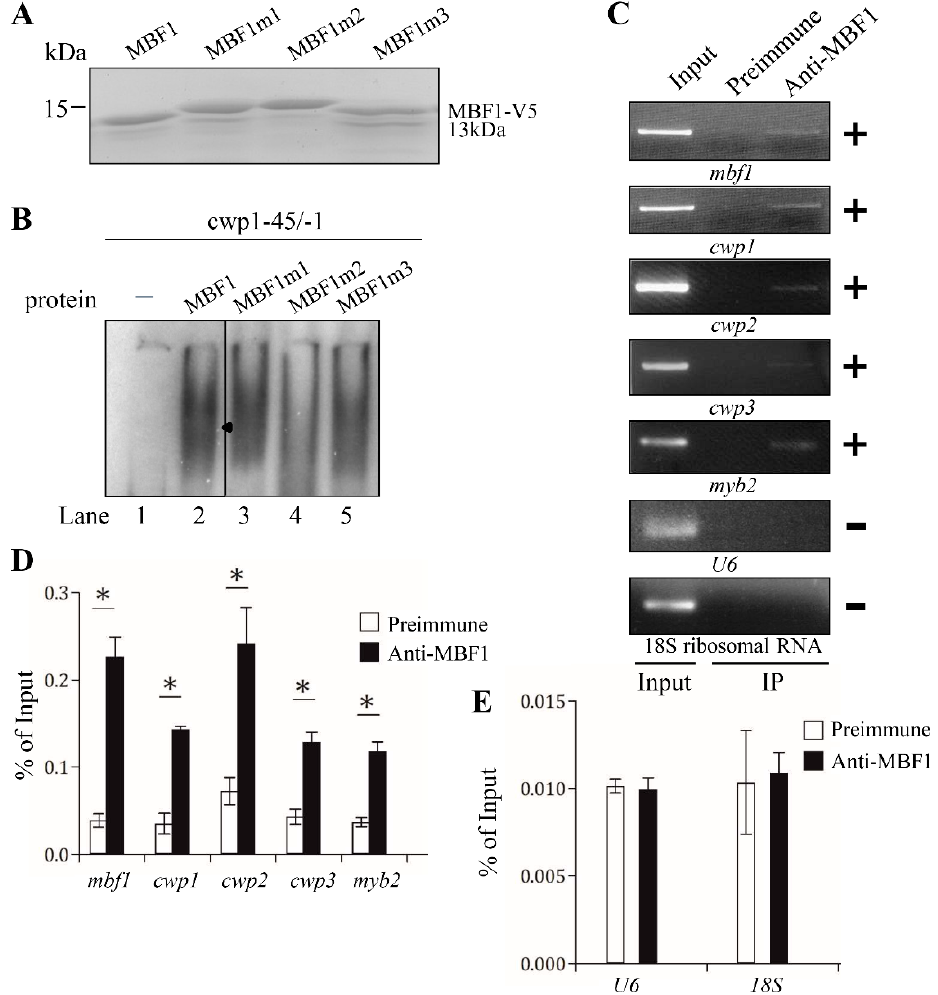
Figure 6. Analysis of the DNA-binding domain of MBF1. ( A ) SDS-PAGE analysis of recombinant MBF1 and MBF1m1-3 proteins. MBF1 or MBF1m1-3 proteins with a C-terminal V5 tag were purified from E. coli by affinity chromatography and then analyzed by SDS-PAGE and silver staining. ( B ) Decreased DNA-binding ability of MBF1m2. Purified MBF1 and its mutants and the 32 P-end-labeled oligonucleotide probe cwp1-45/-1 were used in electrophoretic mobility shift assays. The arrowhead indicates the shifted complex. ( C ) Recruitment of MBF1 to the cwp1-3 and myb2 promoters. The non-transfected WB cells were cultured in encystation medium for 24 h and then subjected to chromatin immunoprecipitation (ChIP) assays. Anti-MBF1 antibody was used to assess interaction of MBF1 to evarious gene promoters. Preimmune serum was used as a negative control. Immunoprecipitated chromatin was analyzed by PCR using primers that amplify the 5 ′ -flank- ing region of the genes indicated in the figure. The anti-MBF1 antibody enriched the mbf1, cwp1, cwp2, cwp3, and myb2 promoter fragments (+), but not the U6 promoter fragment ( − ). The 18S ribosomal RNA gene promoter was used as a negative control ( − ). ( D , E ) ChIP assays coupled with quantitative PCR. Values represented as a percentage of the antibody-enriched chromatin relative to the total input chromatin (% of Input). Results are expressed as the mean ± 95% confidence in- tervals of at least three experiments. *, p < 0.05. 2.7. In Vivo Association of MBF1 with the cwp1-3, myb2, and mbf1 its Own Promoters We further used chromatin immunoprecipitation (ChIP) assays to investigate the in- teraction of MBF1 with specific promoters in the MBF1-overexpressing cell line in vivo. We found that MBF1 associated with multiple regions, including the cwp1-3 and myb2 gene promoters and its own promoter, during encystation (Figure 6C,D). However, MBF1